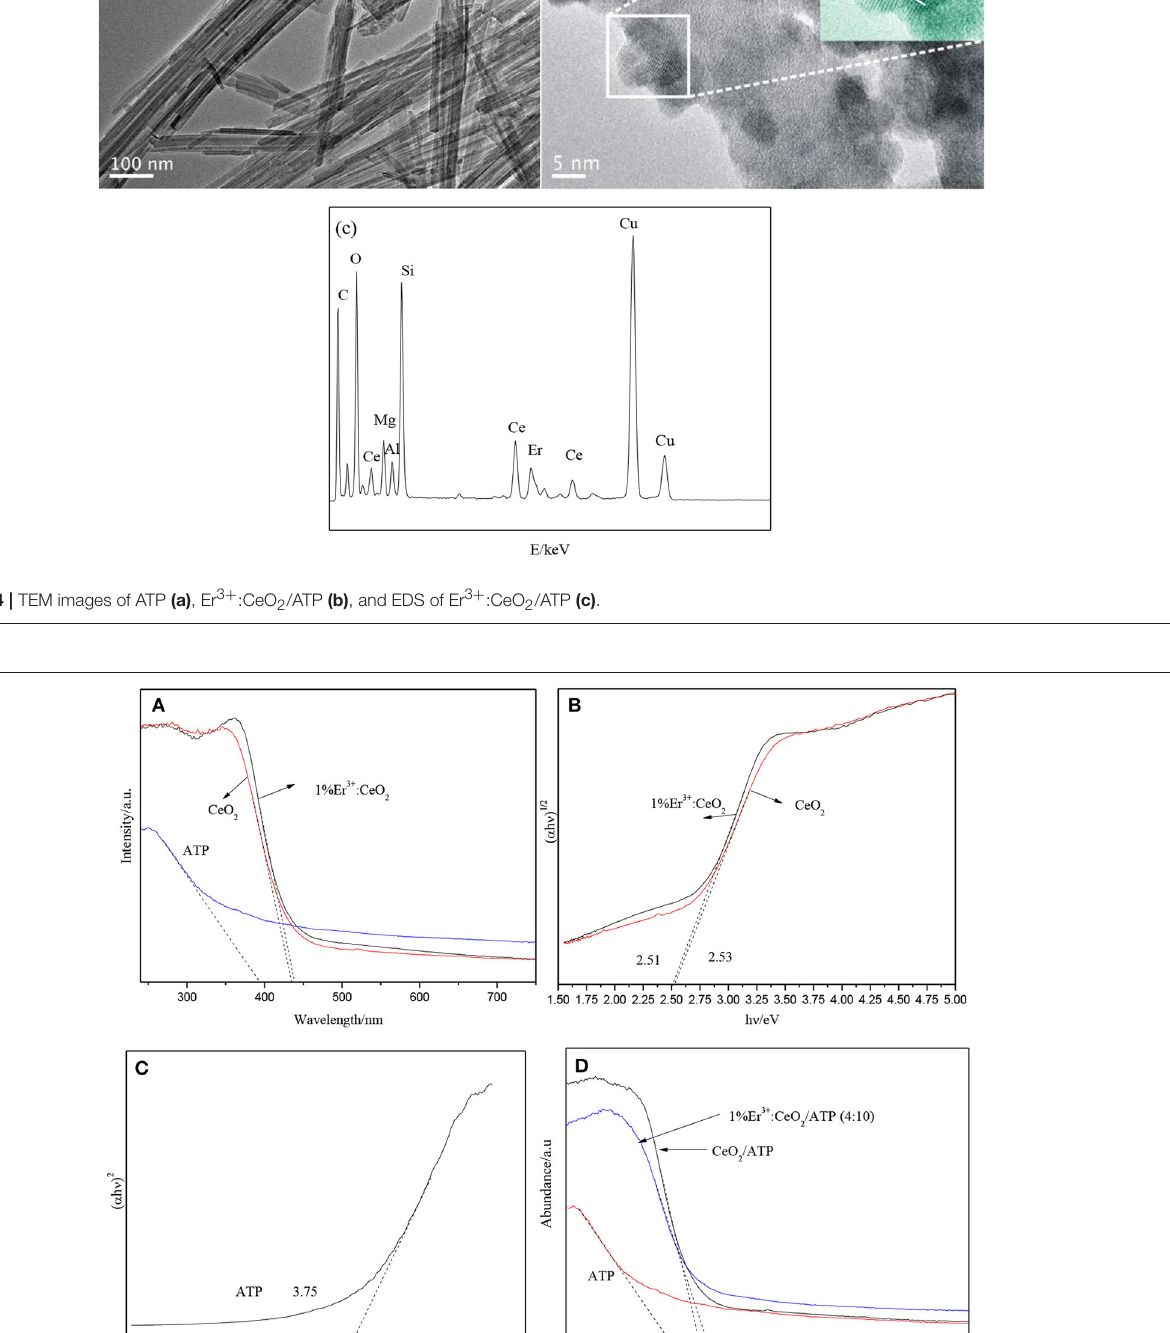
Frontiers in Chemistry | www.frontiersin.org